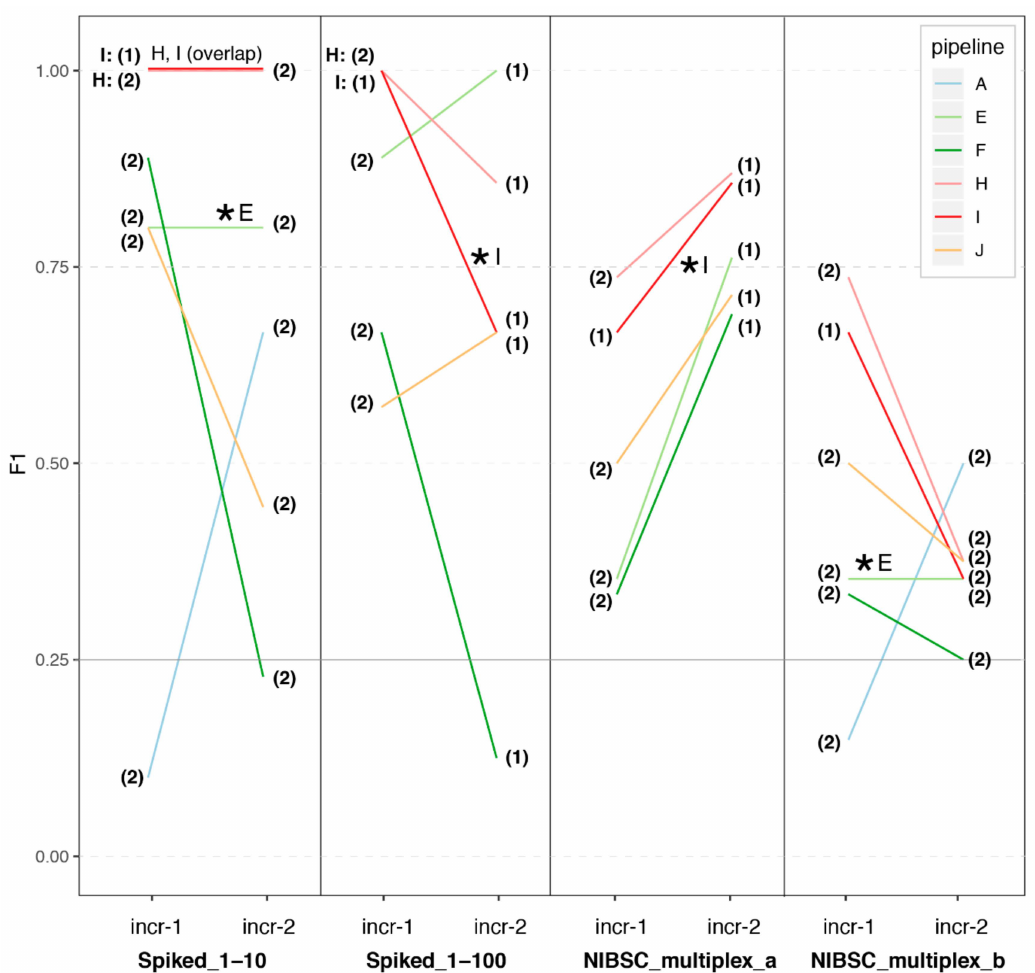
Figure 3. Performance across pipelines on the spiked biological samples (increments 1 and 2). We plot the F1-score obtained by each pipeline on the four spiked biological samples provided in increment 1. We also plot the F1-score obtained by these pipelines in increment 2, on the same samples but starting this time from one common FASTQ dataset that we selected from the FASTQ datasets submitted by participants of increment 1 (indicated by a “*”, see also Table 1 and Materials and Methods). We also indicate with a number if the analyses were based on the single-end ( 1 ) or paired-end ( 2 ) reads. Note that pipeline A did not report any results for two of these samples in increment 2 (Spiked_1-100; NIBSC_multiplex_a), and their results in the corresponding panels are therefore not represented